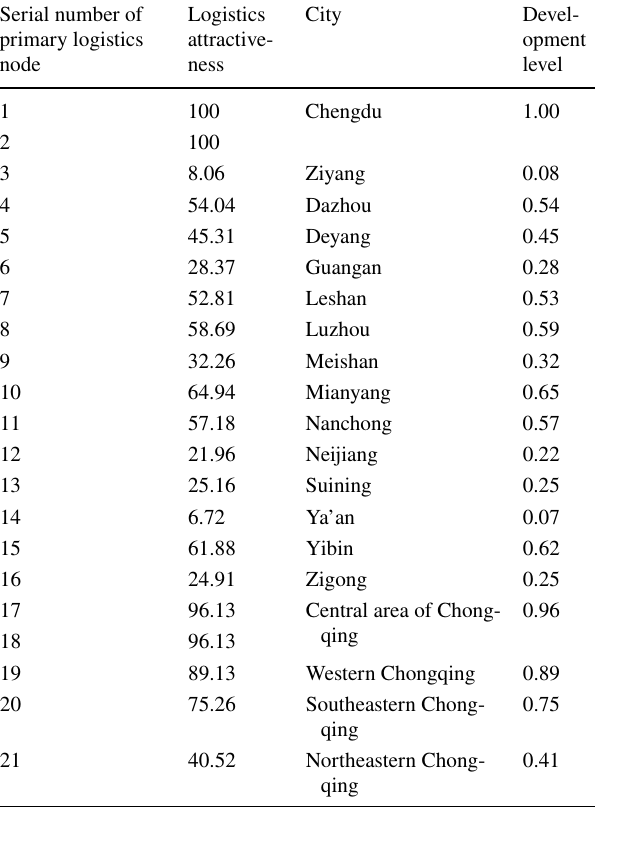
Table 2 Logistics attractiveness of the primary logistics nodes and the development level of the urban logistics industry Serial number of primary logistics